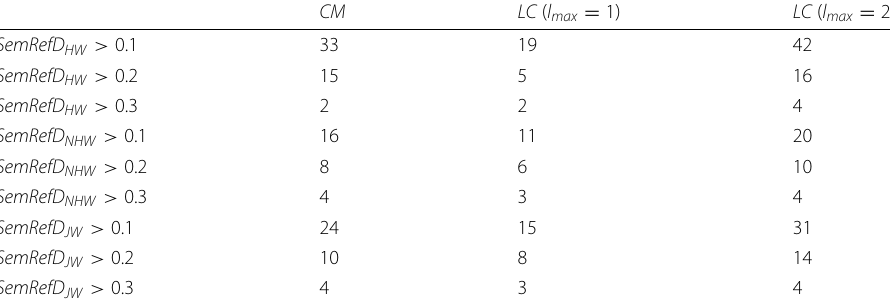
Table 4 Final candidate set size per search / pruning strategy for “Machine Learning” target concept CM LC ( l max = 1) LC ( l max = 2) SemRefD HW > 0.1